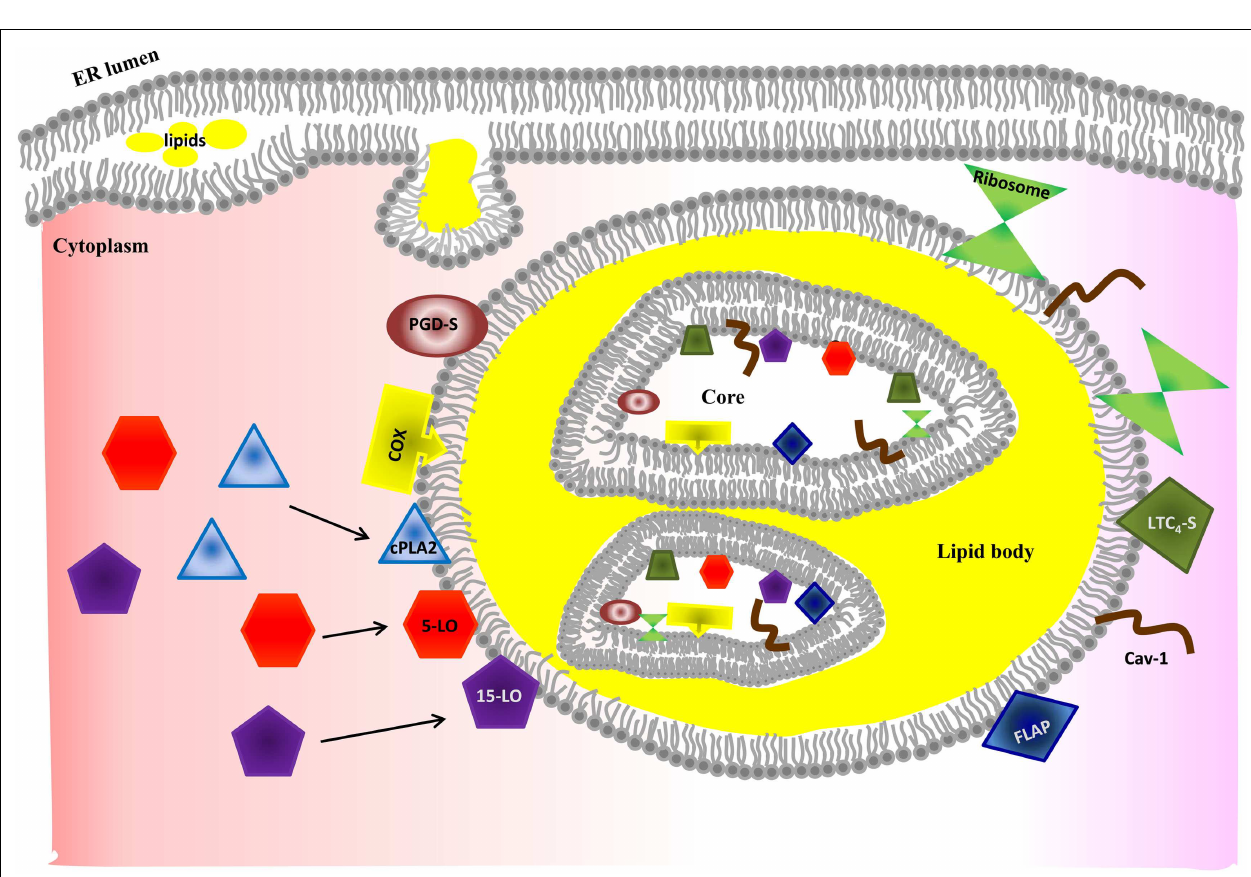
exact mechanism of formation of the bilayer structure is poorly understood. Enzymes required for eicosanoid production have been found in both outer membrane and core of lipid bodies. Increased intracellular Ca 2 + after MC stimulation induces activation and translocation of cPLA 2 , 5-LO, and 15-LO to the lipid body membrane for eicosanoid synthesis. Further studies are required to unveil how MC control synthesis and secretion of arachidonic acid metabolites in a stimulus-specific